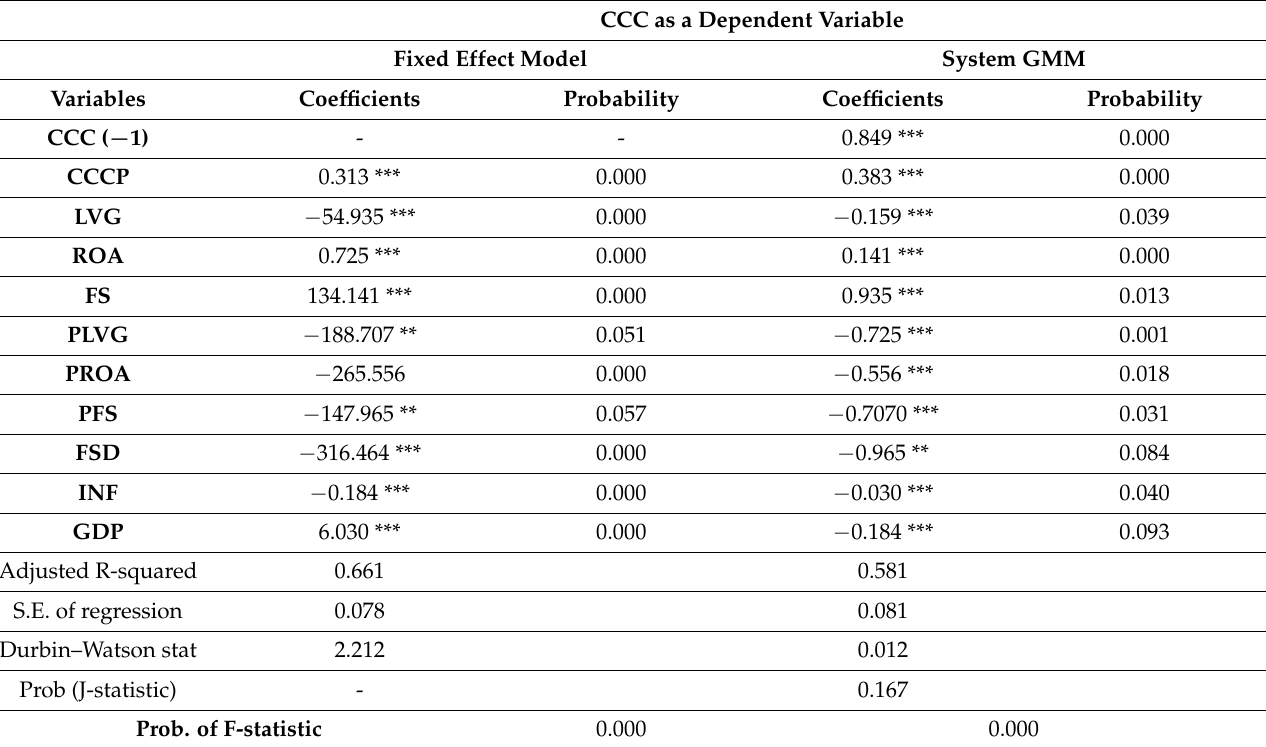
Table 5. Relationship Between Peer and Corporate Working Capital